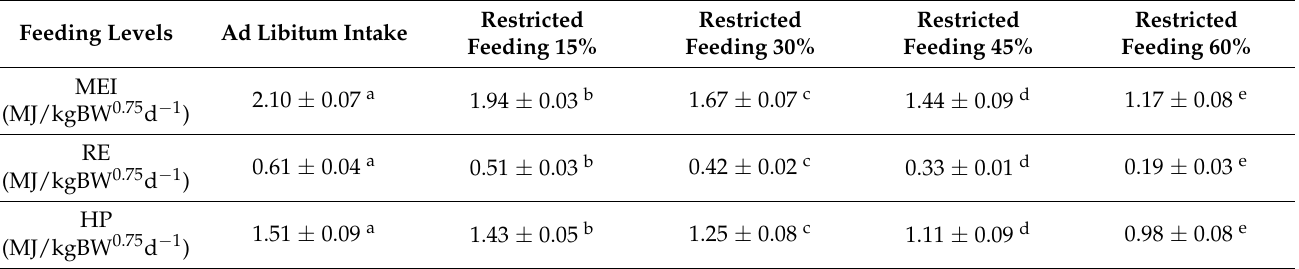
Table 4. ME intake, retained energy and heat production for ducks under different feeding